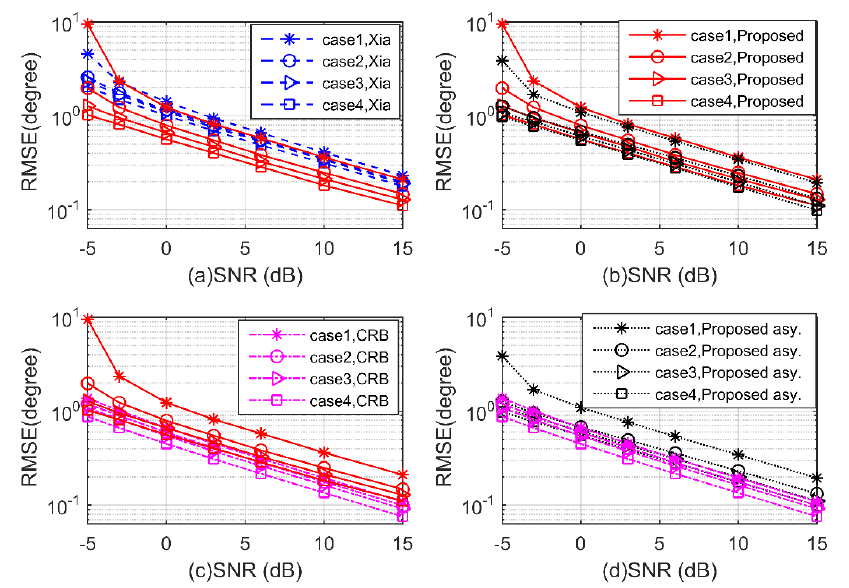
Figure 6. Root mean square error (RMSE) of 2D-DOD for mixed signals versus signal-to-noise ratio (SNR) ( a–d ).